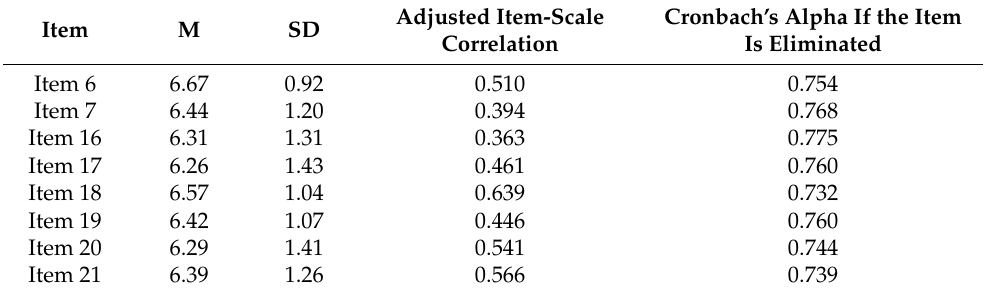
Table 6. Statistical total-item: Features.